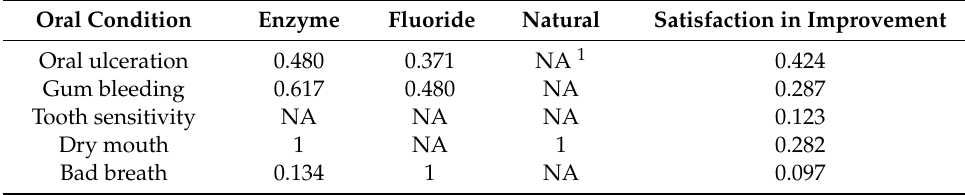
Table 2. The p -value for oral condition before and after the clinical trial and satisfaction regarding improvement among the three